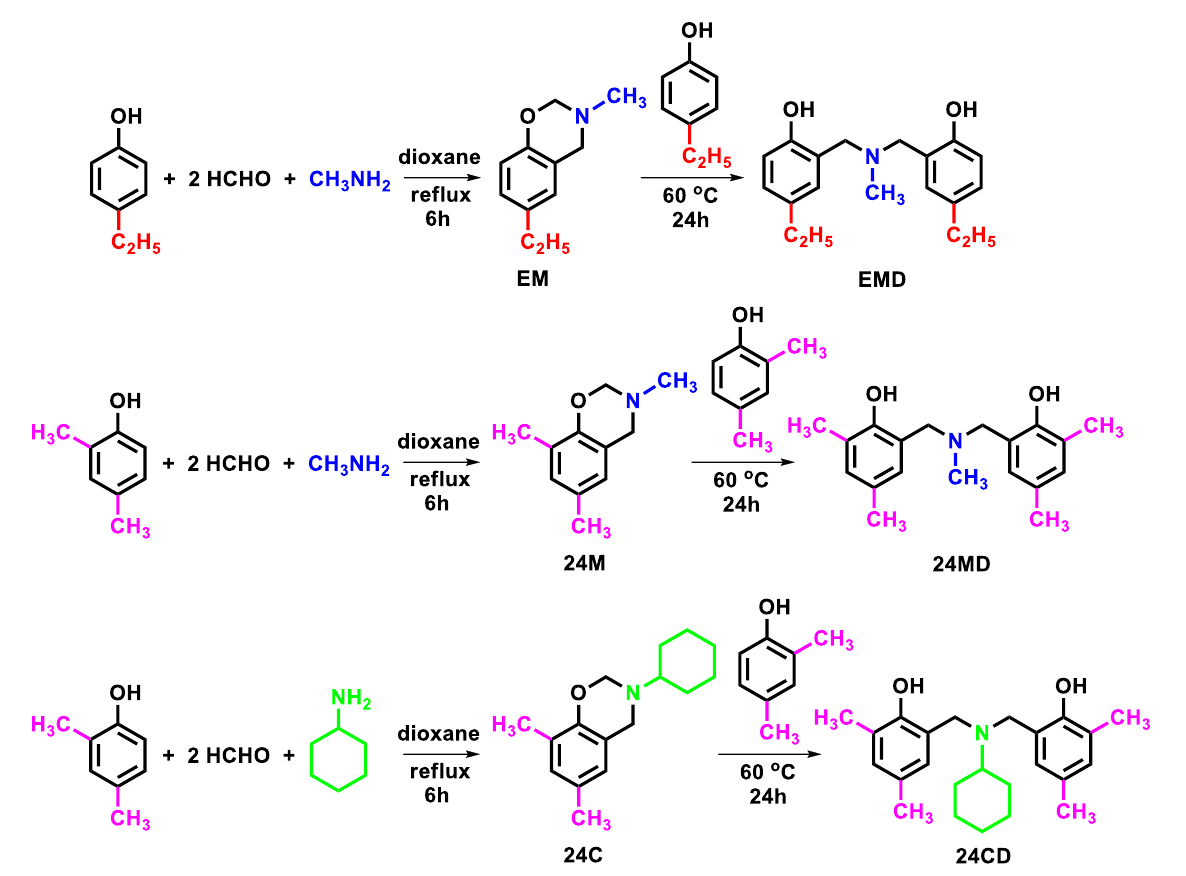
Figure 5 Correction Figure 5. N,N -bis(2-hydroxybenzyl) alkylamine derivatives used in this